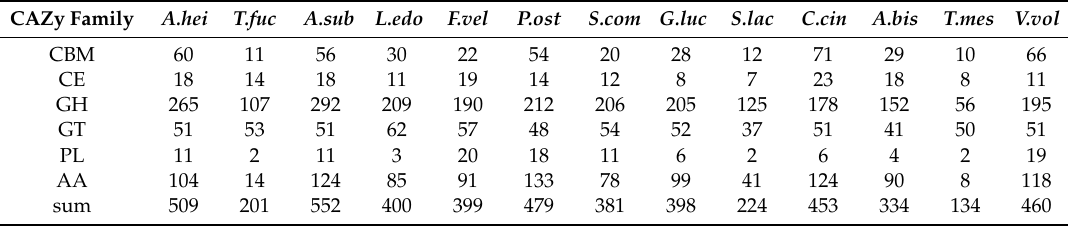
Table 2. The number of CAZymes and AAs of A. heimuer compared with those of other fungi. CAZy